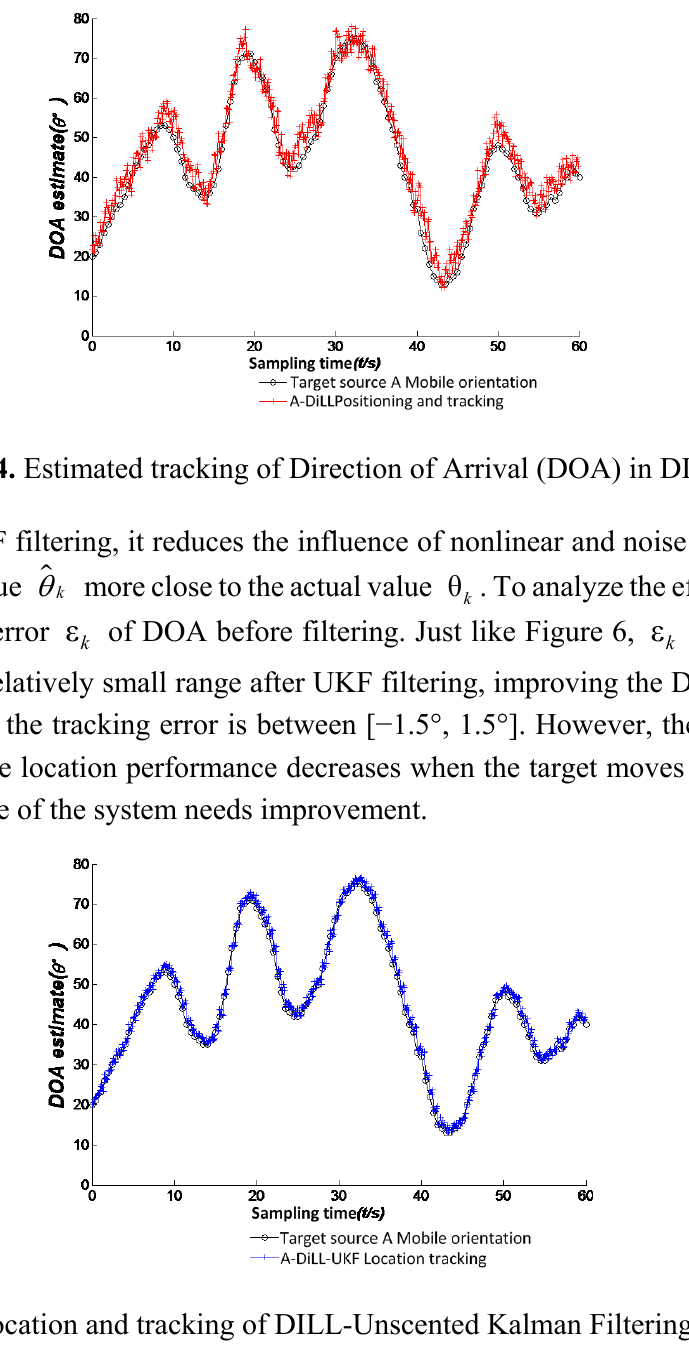
Figure 5. Location and tracking of DILL-Unscented Kalman Filtering